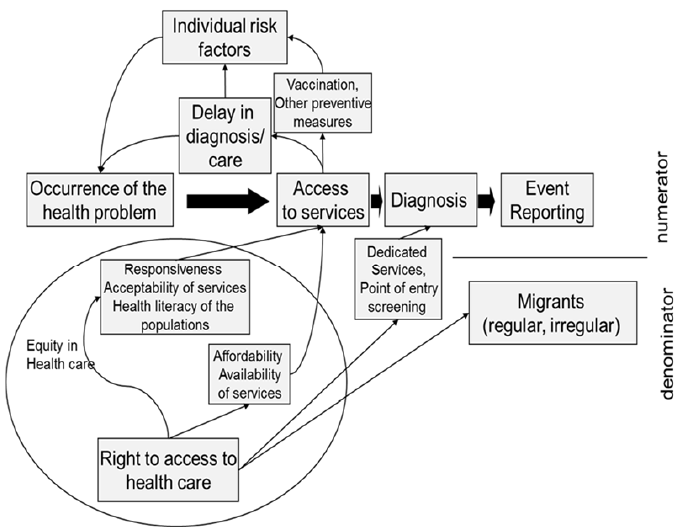
Figure 1. Interaction between migrant access to health care and indicators to monitor infectious diseases. In the middle, the theoretical flow from occurrence of the disease to reporting the event in a surveillance system is represented. Black arrows represent the causal effects of factors that could influence the probability of occurrence of the disease, access to health service, diagnosis, reporting, and computing a correct indicator of infectious diseases in migrants.